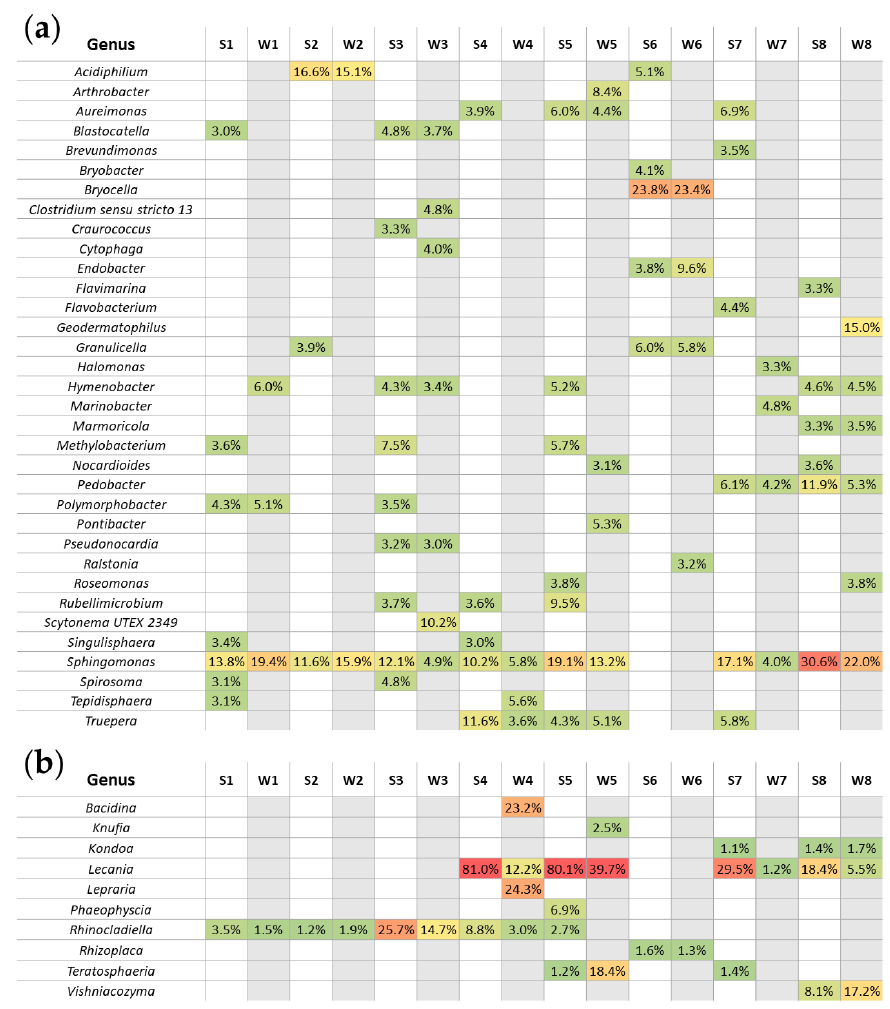
Figure 9. Bacterial ( a ) and fungal ( b ) genera dominating across samples. On two heat map-like figures, genera that represent at least 3% (in case of bacteria) or 1% (in case of fungi) relative abundance in each sample are shown. Overall, there are 34 bacterial genera ( a ) that seem to be the most represented. In case of fungal analysis ( b ), 10 different genera are shown. The abundance of each genus above the threshold was colored from green (the smallest percentage) to red (the highest percentage) while the empty cells were colored according to the season, i.e., white–summer (S prefix), grey–winter (W prefix).